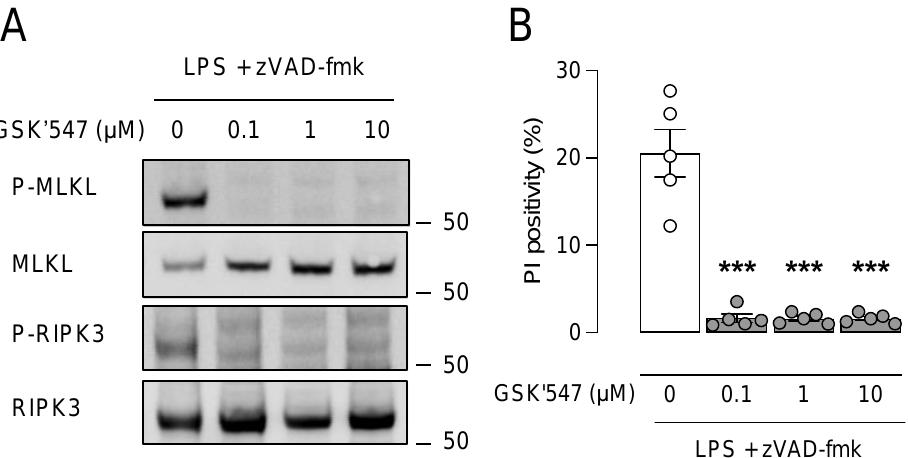
Figure 4. GSK’547 protects macrophages from LPS/zVAD-fmk-induced necroptosis. Bone marrow- derived macrophages (BMDMs) were isolated from wild-type mice and treated with 50 ng/mL LPS and 20 µ M zVAD-fmk in the presence or absence of GSK’547 for 18 h. ( A ) Western blot analysis of necroptosis proteins (MLKL, RIPK3) on cell lysates. ( B ) Cell death was measured using propidium iodide (PI) labeling. *** p < 0.001 vs. 0 µ M GSK’547 (one-way ANOVA followed by Dunnett’s post hoc test, n = 5 independent